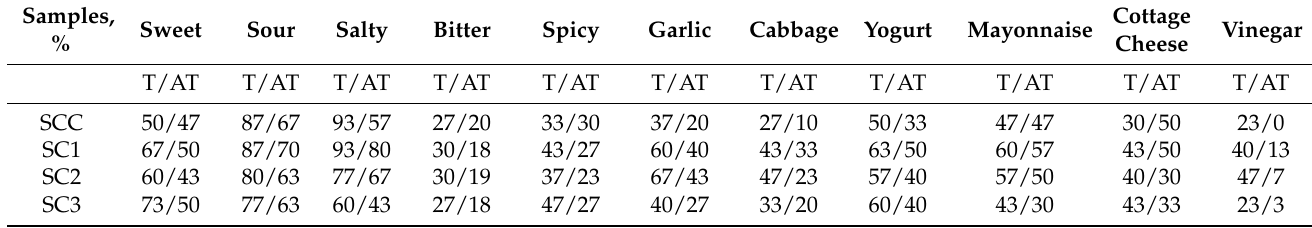
Table 6. The percentage of terms used to describe the taste (T) and aftertaste (AT) of the experimental samples with sour